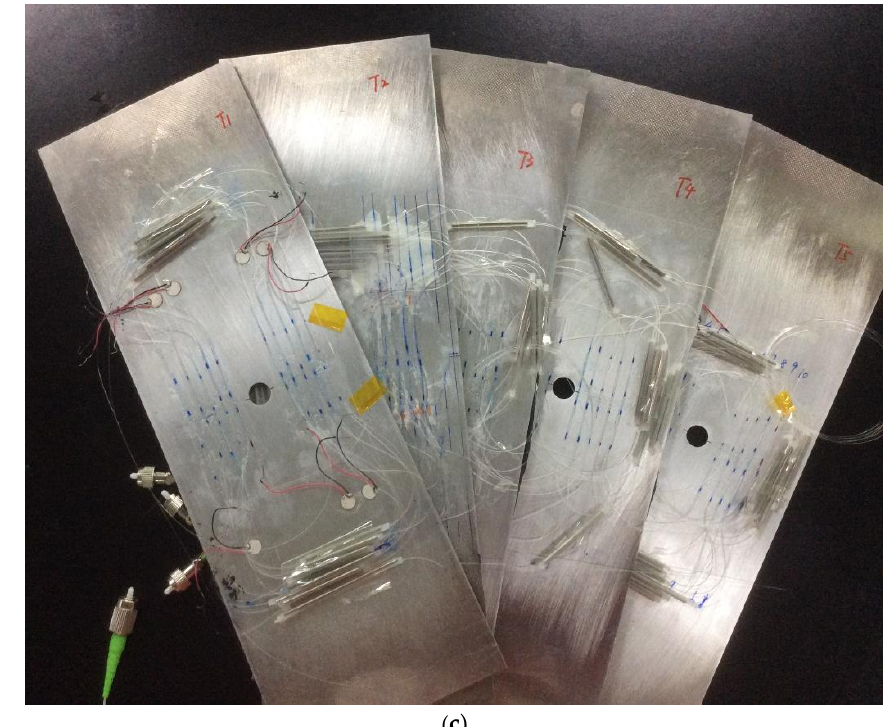
Figure 7. ( a ) Schematic of the aluminium specimen. ( b ) The FBG sensor network design. ( c ) The parallel specimens.